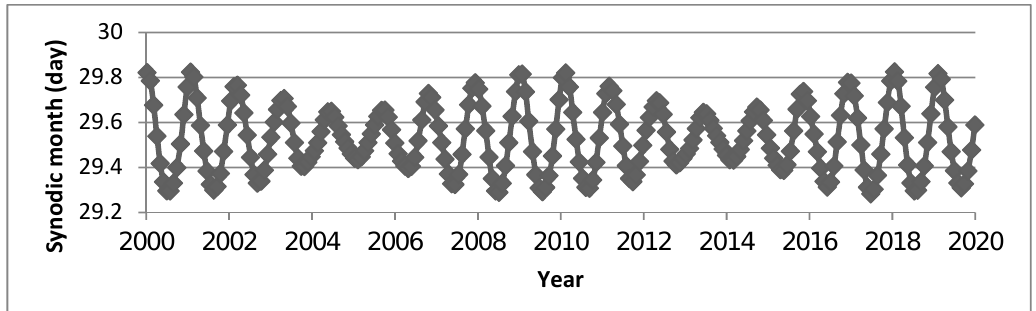
Fig.3: Period for the synodic month trough